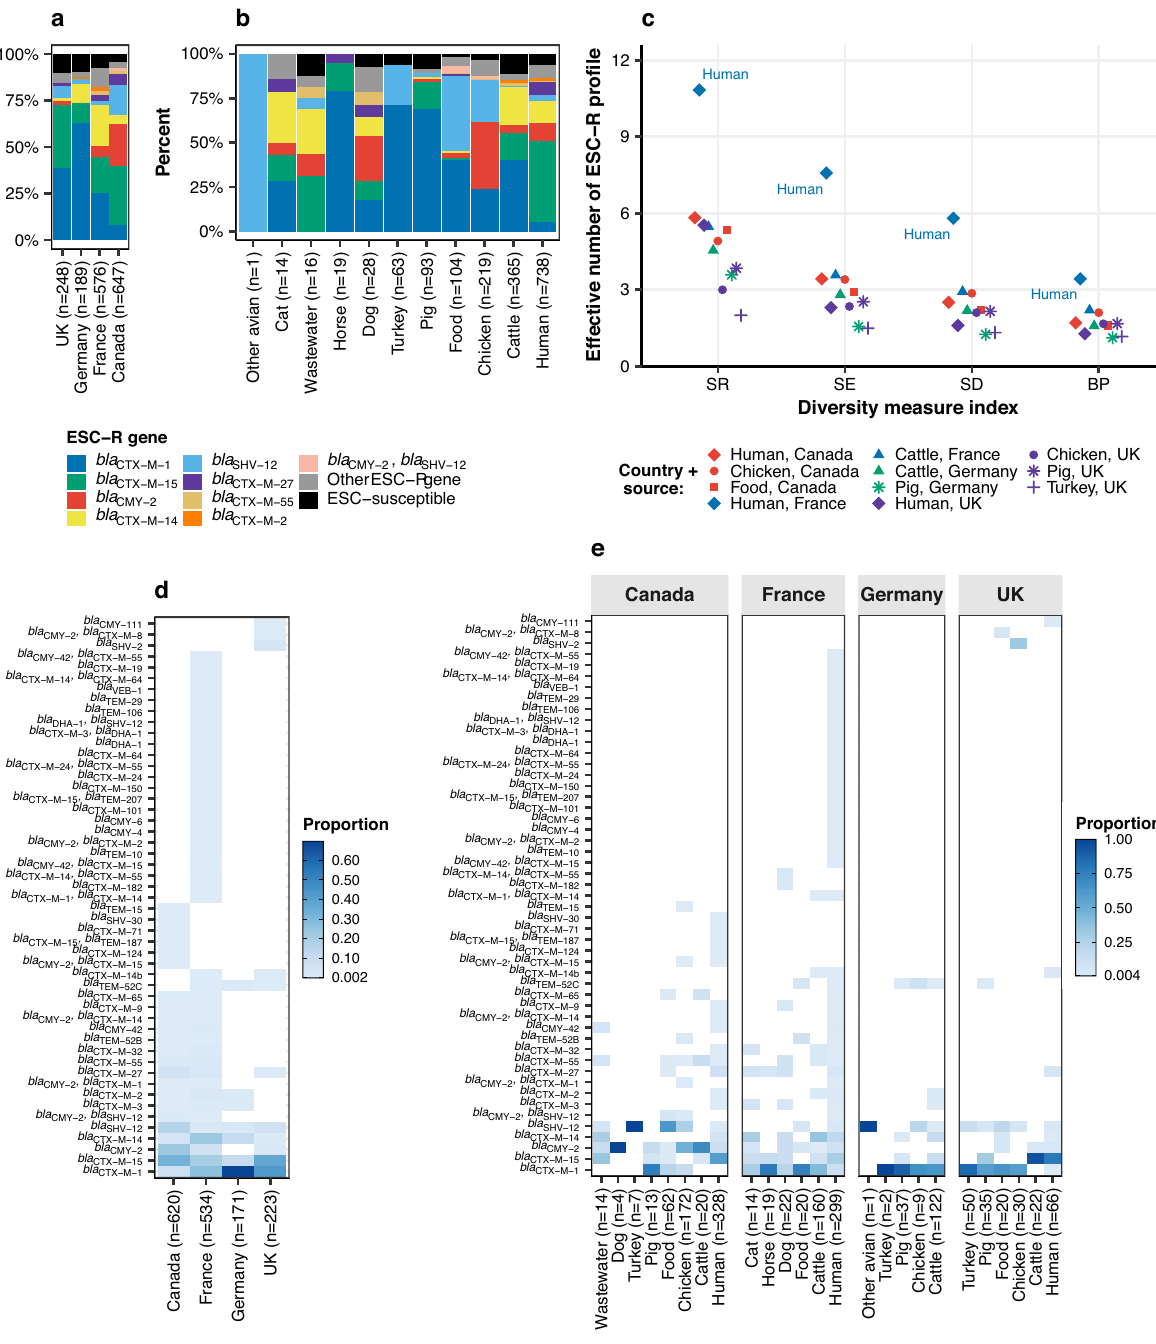
is linked with the source and the colours with the country. d Common and unique ESC-R genes among countries and e compartments (total n =1548 ESC-R gen- omes*). Heatmaps are coloured as per inset scale bars. *Genomes from Pietsch et al. 22 ( n =158; 148 ESC-R genomes+10 ESC-susceptible genomes) were excluded. Source data are available in the Source Data fi le. ESC-R: extended-spectrum cephalosporin